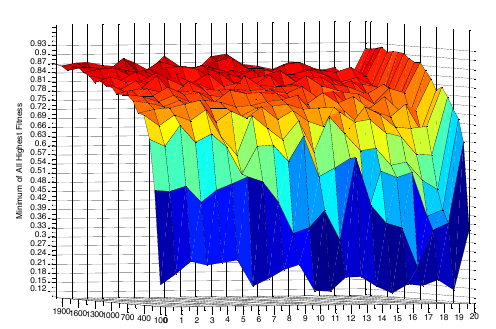
Figure 4.1.1 Mean Fitness of All Highest Fitness